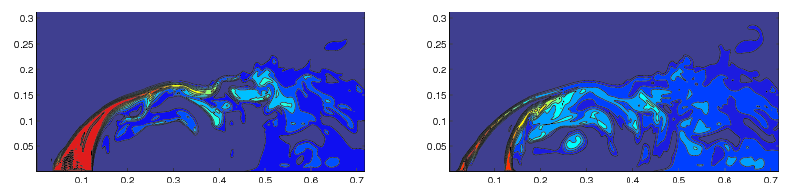
Fig. 2 Scalar fractions in a coannular jet-in-crossflow arrangement. Main flow is from left to right, the co-annular jet enters through the bottom wall. 3D DNS with around 21 million grid cells. Red indicates high values of the scalar, Blue low values. Left figure shows the scalar fraction for the central stream, right figure for the annular